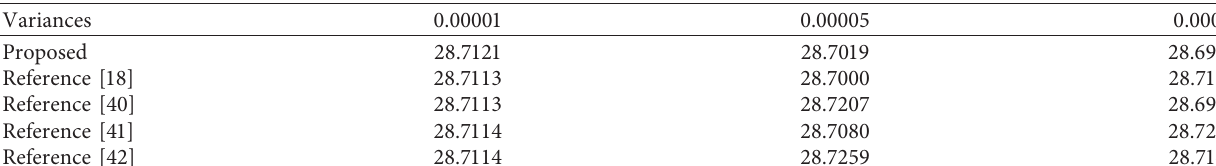
Table 9: Noise attack analysis-II